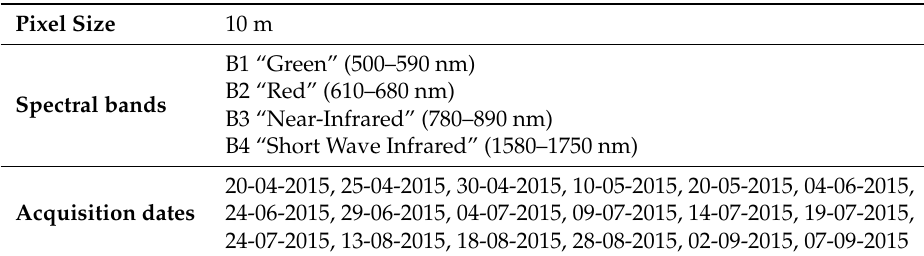
Table 1. Characteristics of SPOT5 (Take5) imagery used in this